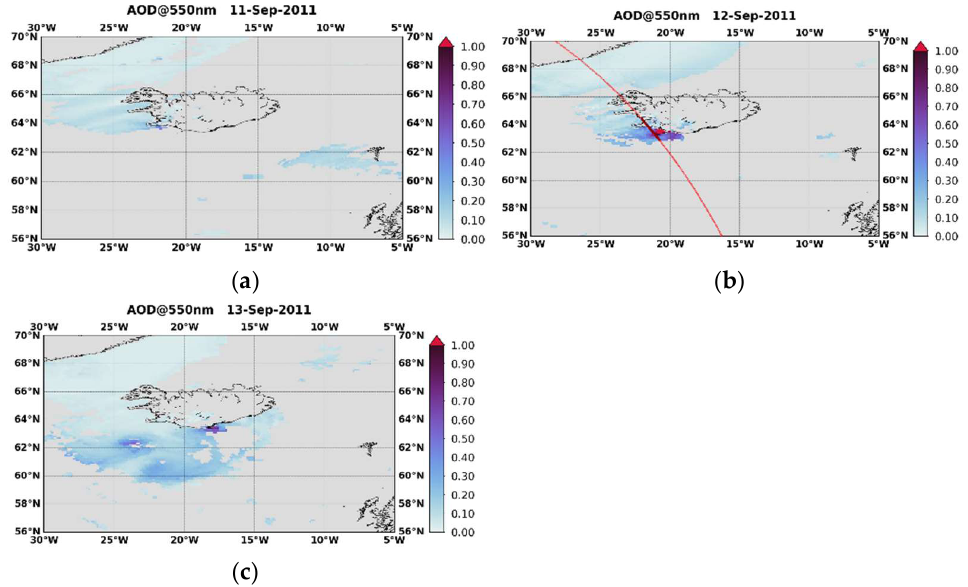
Figure 10. ( a – c ) MODIS–Aqua AOD at 550 nm representing dust pattern over the period of 11–13 September 2011. The red line on the 12 September ( b ) image shows the only available CALIPSO overpass.